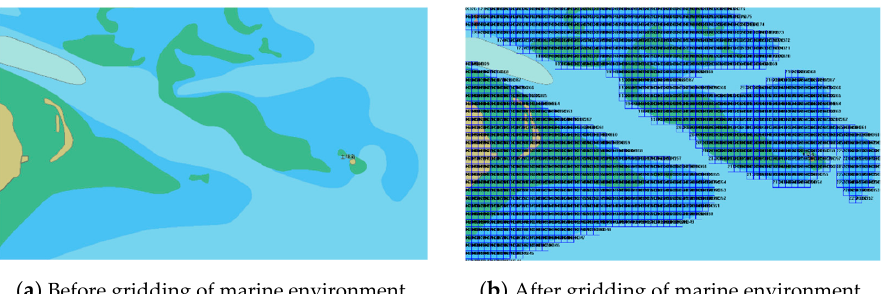
( a ) Before gridding of marine environment. ( b ) After gridding of marine environment. Figure 2. Gridding process of marine environmental: ( a ) before gridding of marine environment; ( b ) after gridding of marine environment.